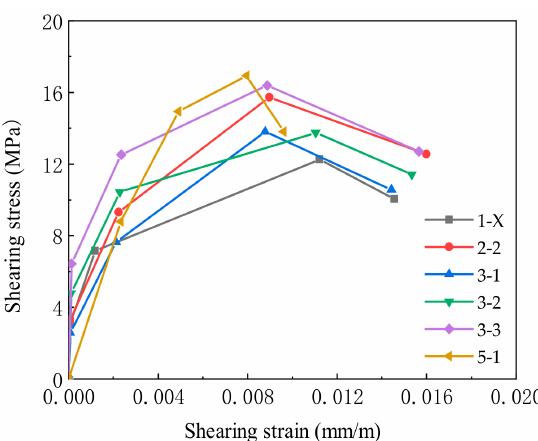
Figure 11. Selection of key points of shear block components in the joint core area (note: 1–X includes BCJ1–0, BCJ1–1, and